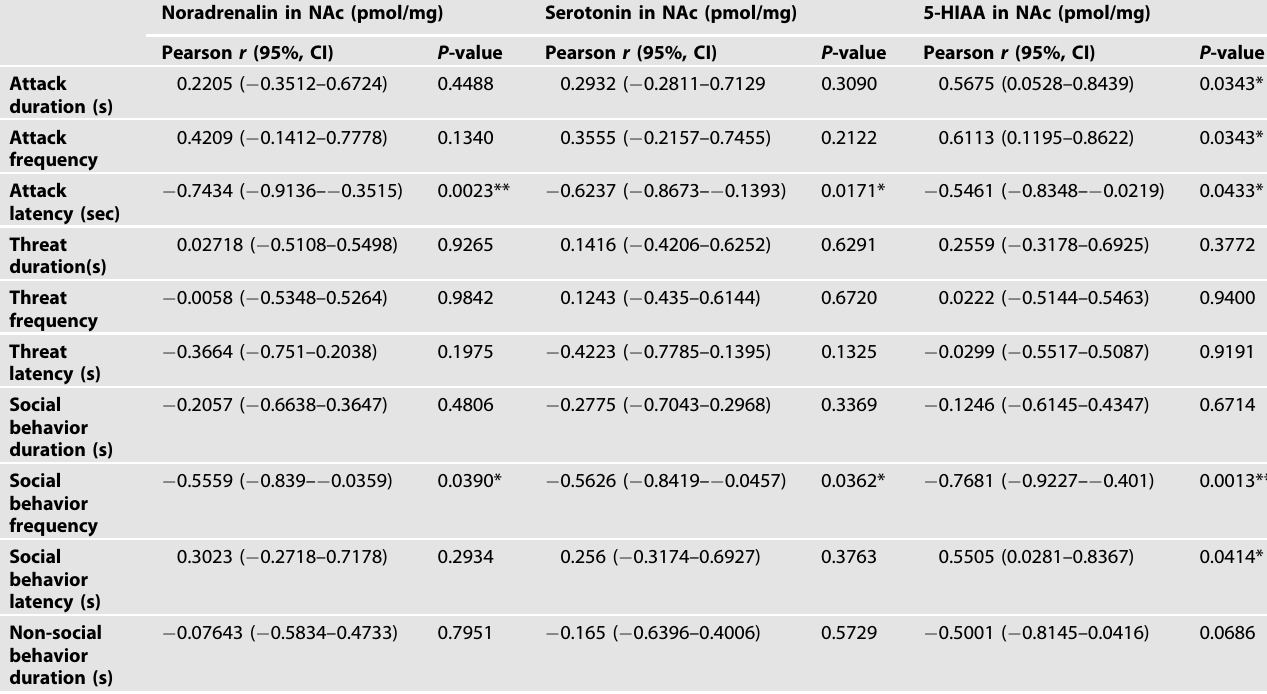
Table 5. Correlational analyses between levels of noradrenaline, serotonin or 5-HIAA in nucleus accumbens (NAc) and behaviors in male mice from the resident intruder test which were injected repeatedly with exendin-4 or